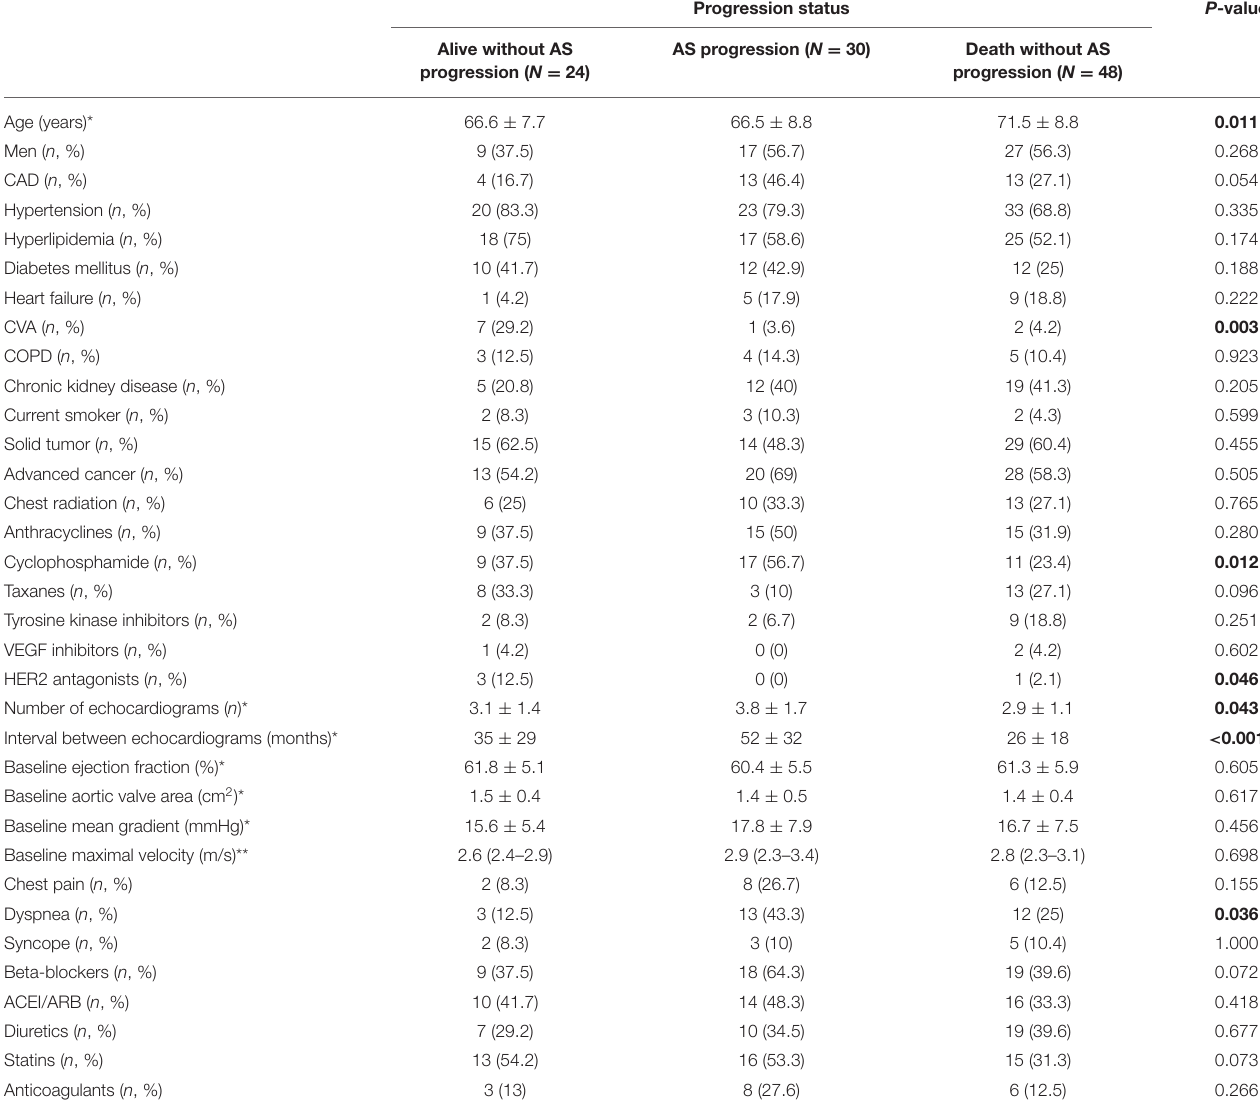
Progression status P